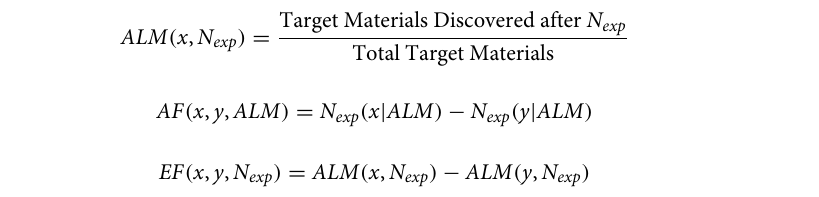
Figure 4 highlights the campaigns that we performed to benchmark the sequential learning models. In “Boundary cases: all or no DFT data available” (corresponds to campaign A), we demonstrate the performance gains which come from an agent with full a priori knowledge of DFT calculations soliciting experimental data versus an agent which never uses DFT data exploring the same space of experiments. Next, in “In-tandem acquisitions: both DFT and experiment data are acquired” (corresponds to campaign B), we compare the performance of agents seeded with first 500 experimentally discovered compositions in a multi-fidelity versus single-fidelity context, where either both DFT and experimental data are solicited in-tandem (with some DFT data supplied a priori) or exclusively experimental data seeded and solicited. In both cases, we find that the performance of multi-fidelity agents are improved by the inclusion of low-fidelity DFT